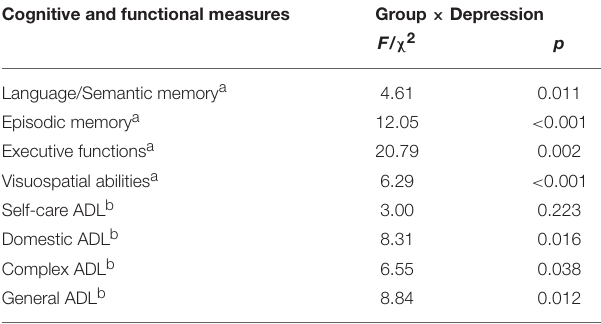
TABLE 3 | Interactions between group (NA × MCI × AD) and depression (present × absent) in cognitive factors and functional measures. Cognitive and functional